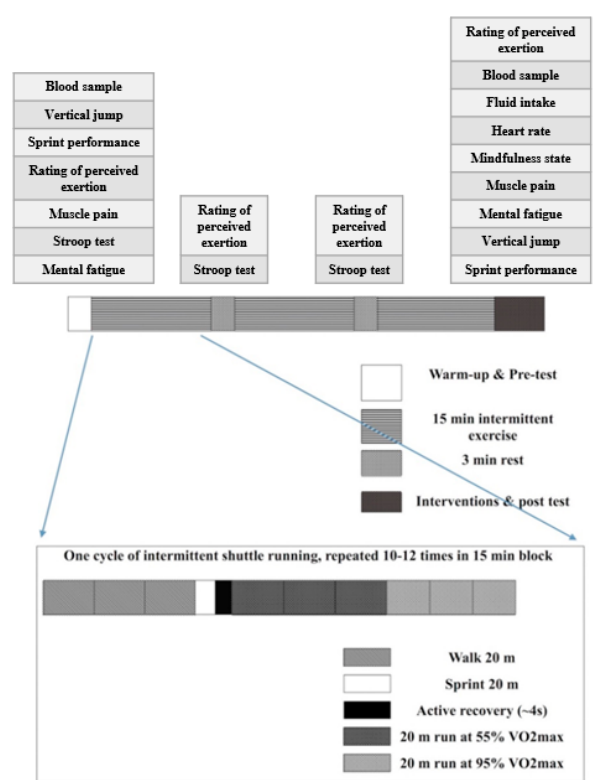
Figure 1. Adopted from the Loughborough Intermittent Shuttle Test.